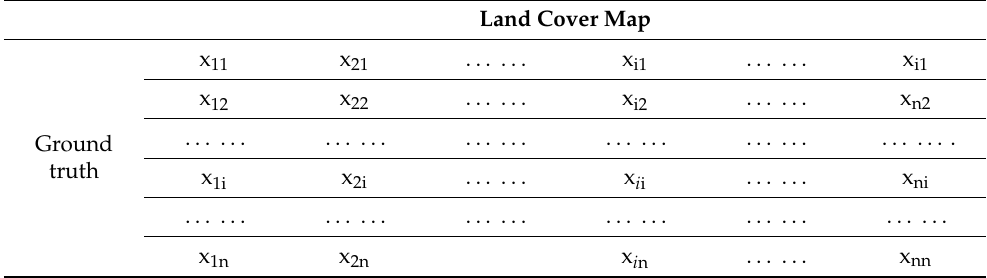
Table 3. Confusion matrix.